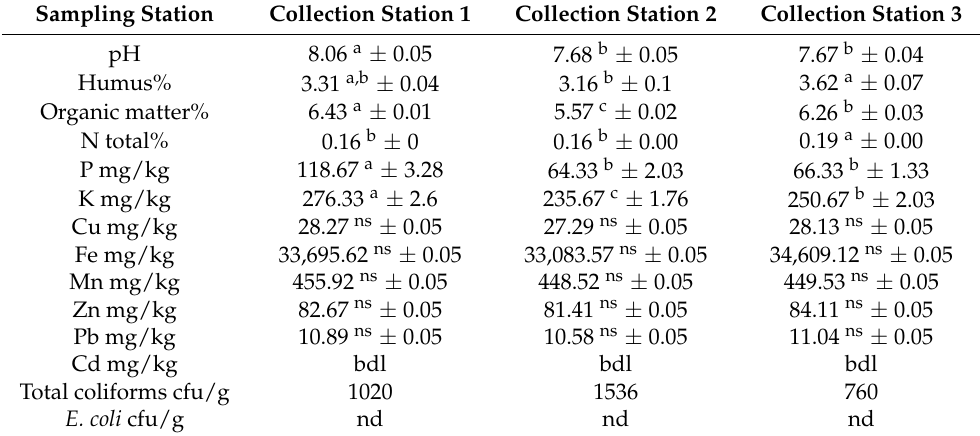
Table 1. The chemical and microbiological composition of the commune carp pond sediments.